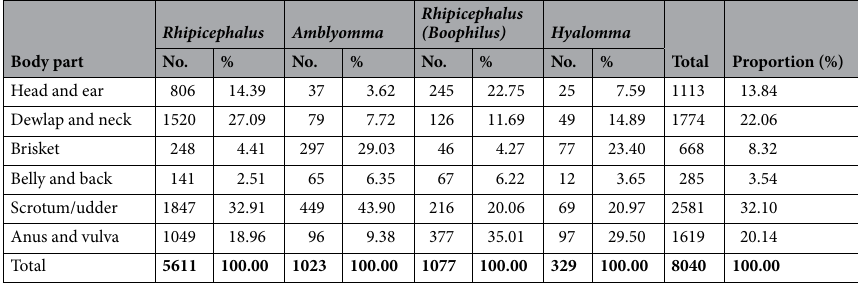
Table 6. Proportion and tick distribution in various body parts within the study districts. Significant values are in [bold].